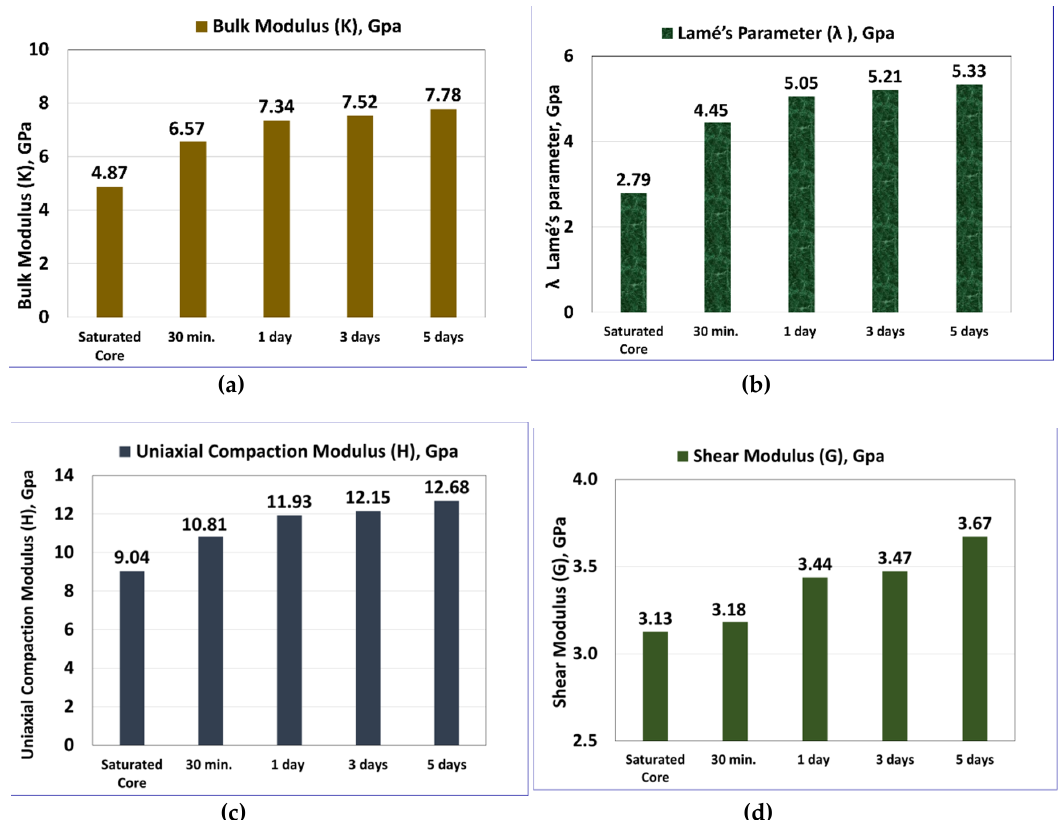
Figure 5. Geomechanical elastic moduli for the samples with extended exposure time: ( a ) K , ( b ) λ , ( c ) H , and ( d ) G .